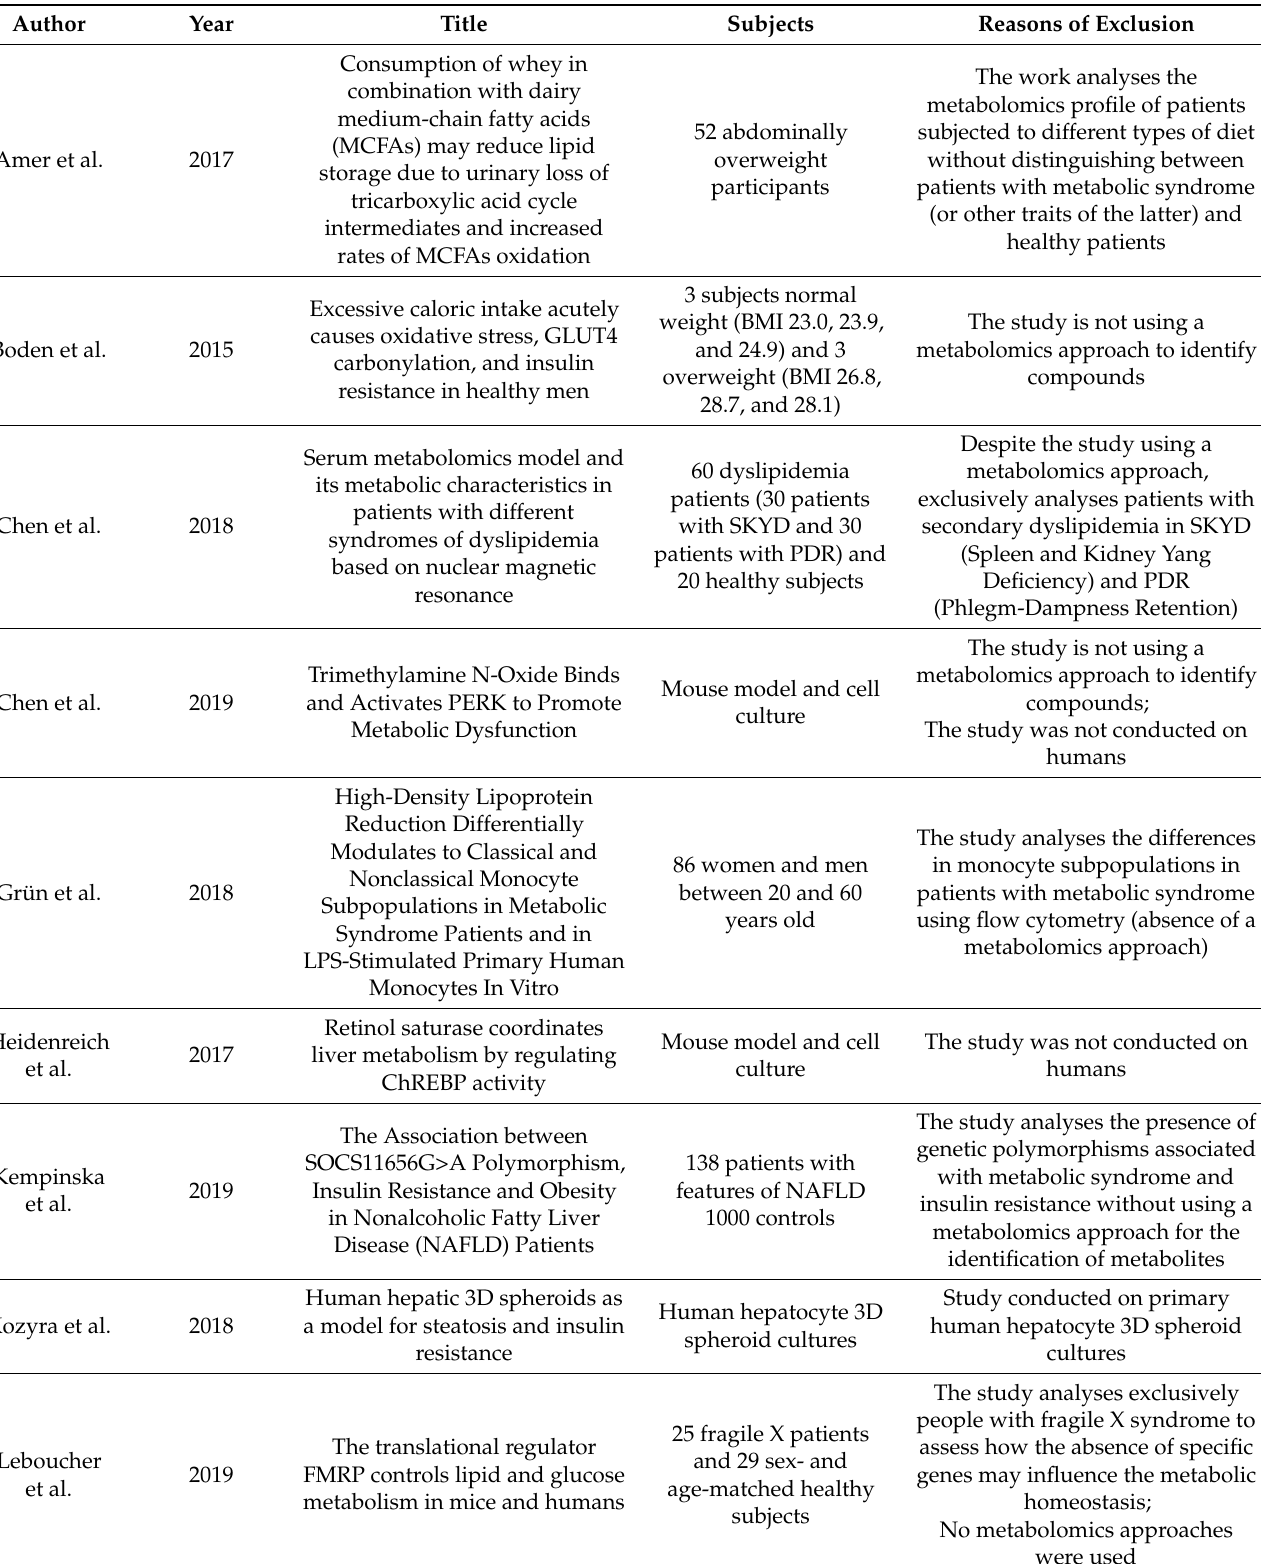
Table 1. Studies excluded after full text